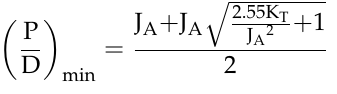
Figure 4. Percentage of change in engine characteristics for different hull roughness.